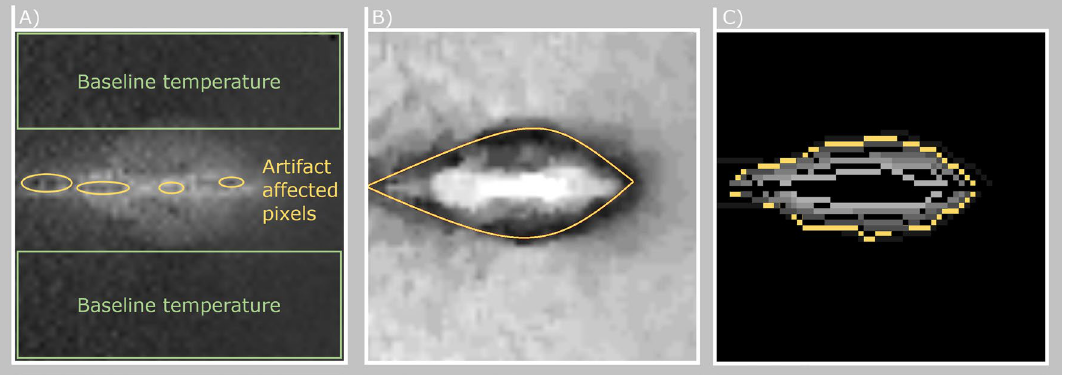
Figure 1. ( A ) Temperature map after computation of the temperature values using the PRFS method. No color- coding was applied for better visibility of baseline temperature (background temperature without any heating) and artifact affected pixels (within and around the needle axis caused by signal cancellation and air). ( B ) Pathfinding map for determining contour line of equal temperature. Darker areas depict regions of low cost for the path finding algorithm. Yellow = Extracted isoline. All values in ( A ) and ( B ) are in the range of [0,100]. ( C ) Eight extracted isotherms within a range of 24 ◦ C color-coded on a grey-scale. The highlighted yellow isotherm corresponds to 21 ◦ C.